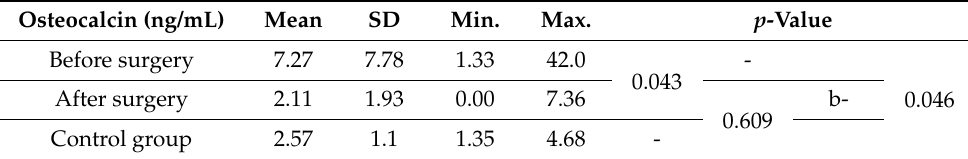
Table 4. Serum concentrations of osteocalcin in study group vs. control group.